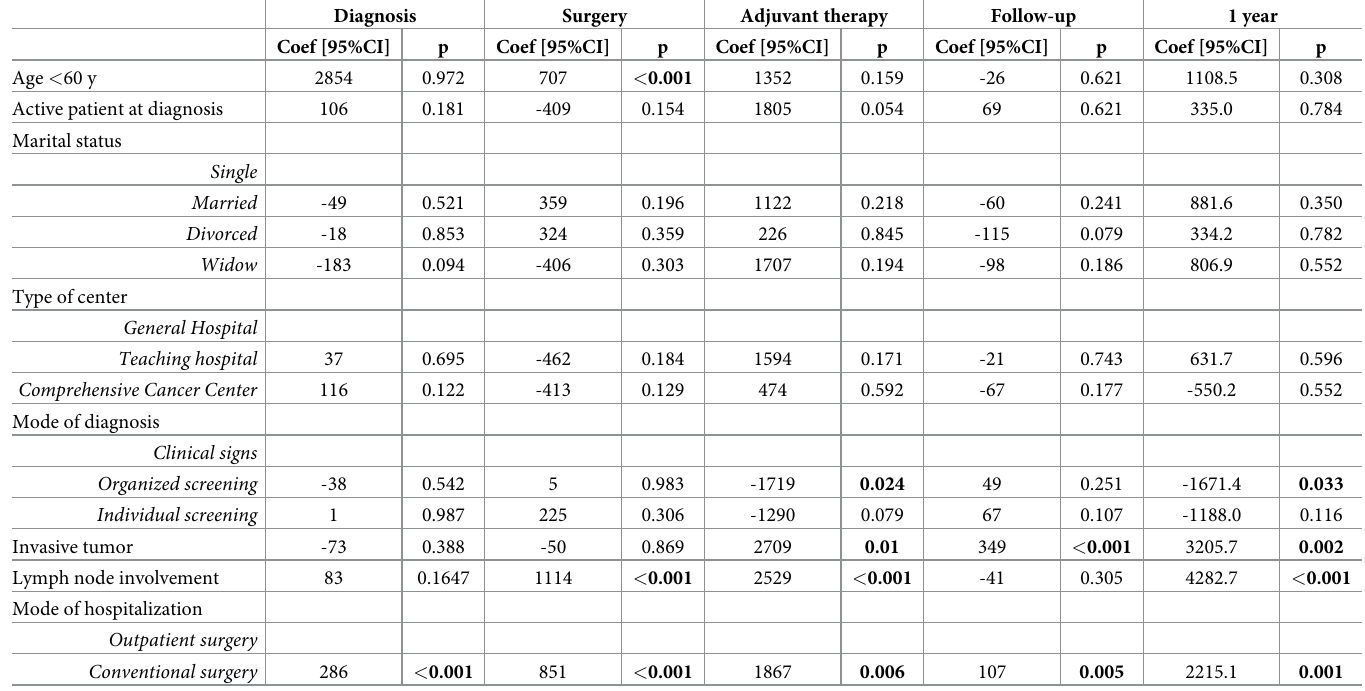
Table 4. Multivariate analysis of the determinants of direct medical costs (multiple linear